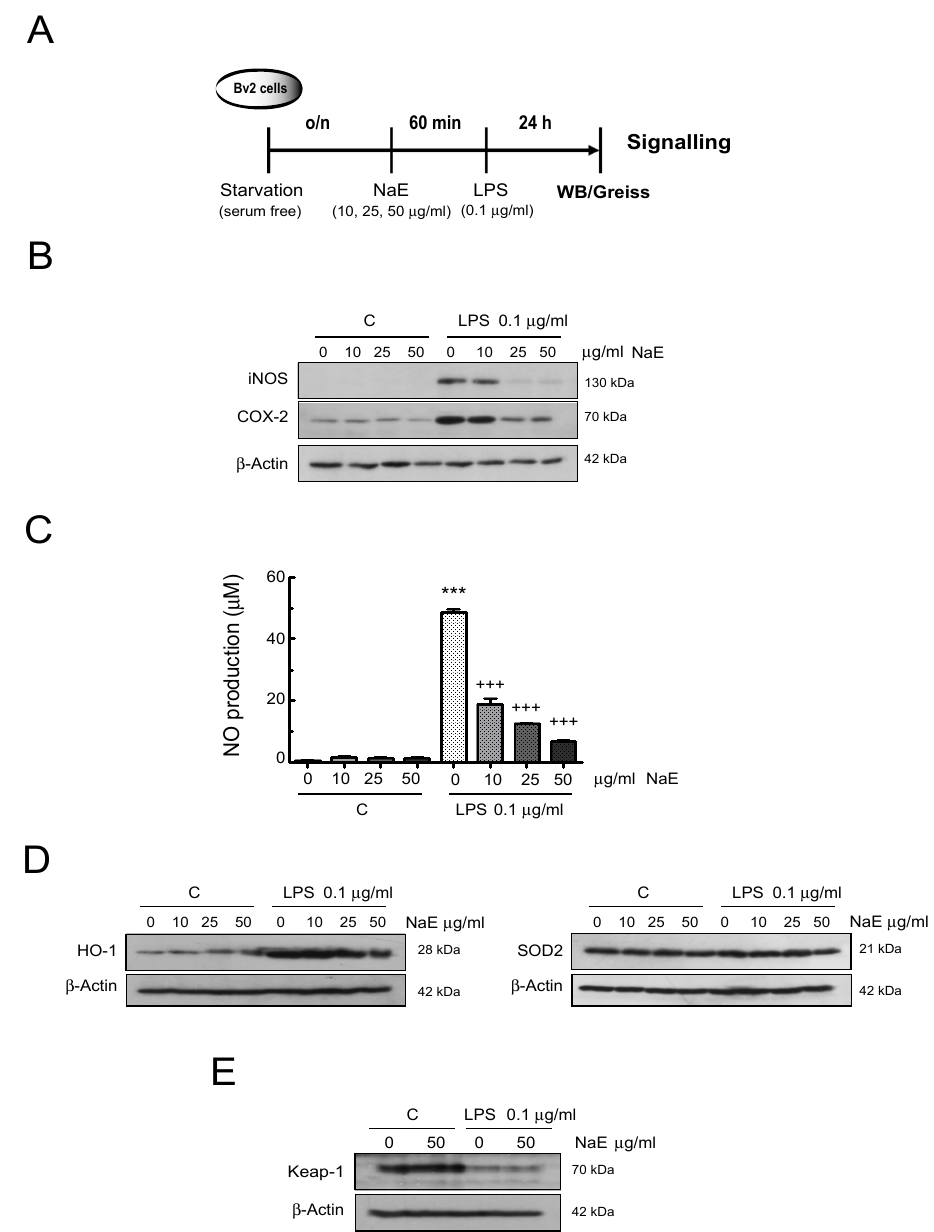
Figure 3. Anti-inflammatory effect of NaE on BV2 cells. ( A ) Experimental steps. BV2 cells were incubated for 1 h at 37 °C with the indicated doses of the NaE extract and then stimulated with or without 0.1 µg/mL of LPS for 24 h. ( B ) Expression of COX-2 and iNOS analyzed by western blot using specific antibodies. ( C ) NO accumulation in the cell culture supernatants analyzed by a Griess assay. Values are means ± SD (n = 3–5). *** p < 0.001 vs. controls; and +++ p < 0.001 vs. LPS-treated cells. Expression of ( D ) HO-1 and SOD2 as well as ( E ) Keap-1 analyzed by western blot using a specific antibody. Western blot bar graphs are in Supplementary Material Figure S3. Based on evidence supporting that NO, MAPK family kinases and redox-sensitive transcription factors such NF- κ B are involved in the modulation of the phase II antioxidant heme oxygenase-1 (HO-1), we investigated the effects of NaE on the expression of this inducible enzyme with immunomodulatory functions [32,33]. The results indicated that LPS enhanced HO-1 protein levels, and the combination of different doses of the extract with LPS reached almost the same effect as LPS alone (Figure 3D). Moreover, the